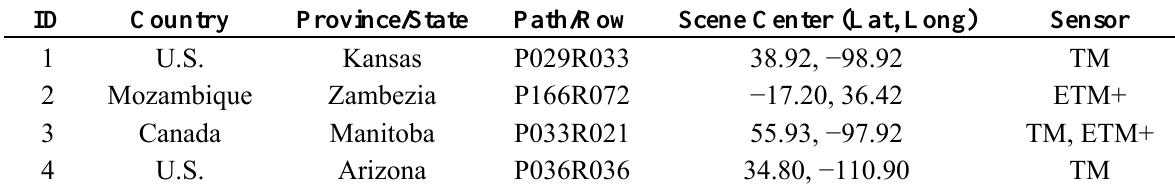
Table 1. List of study locations and Landsat scenes.